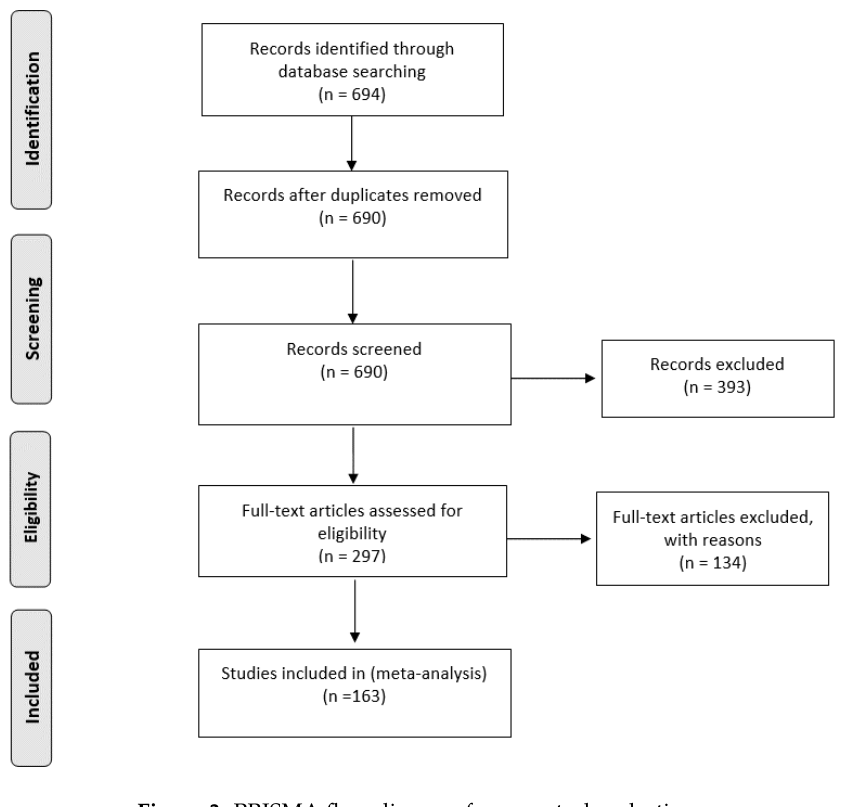
Figure 3. PRISMA flow diagram for case study selection.